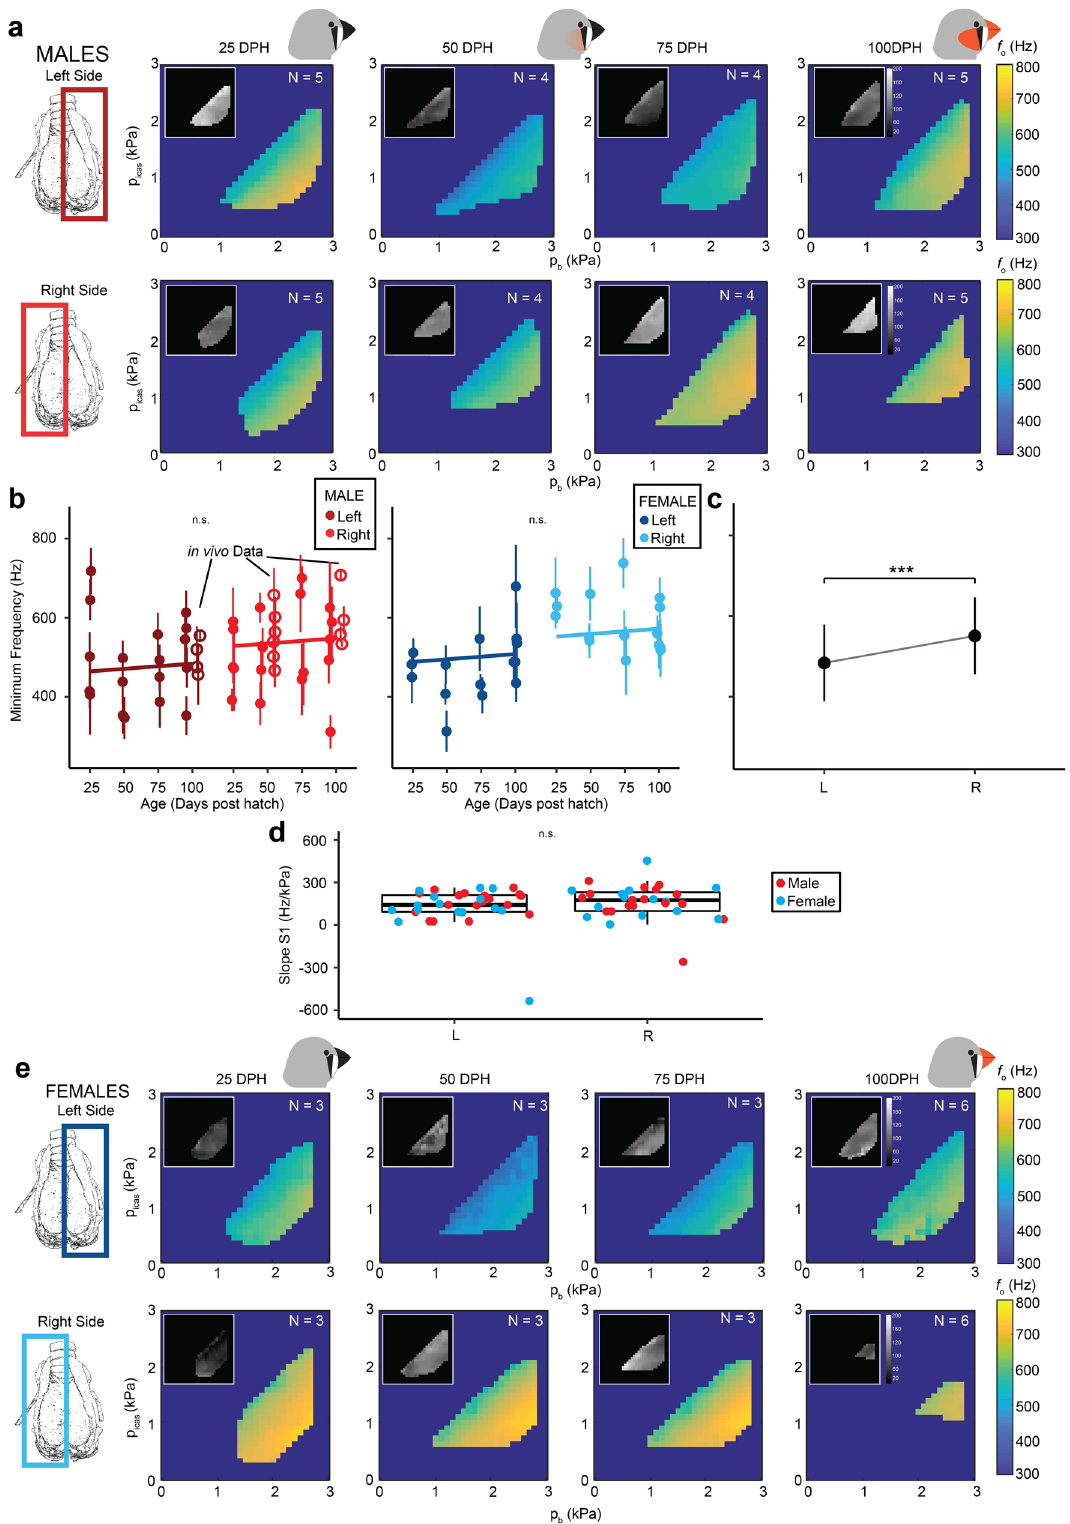
Figure 5. Minimal frequency does not change over zebra finch song development. ( a ) Mean and S.D. (inset) fundamental frequency in the p b − p icas pressure control space for the left and right hemi-syrinx in males over vocal development. ( b ) Minimum f o does not change with age in males and females. ( c ) Minimum frequency was significantly different between the left and right hemi-syrinx, regardless of age or sex. ( d ) Slope S1 for the relationship between f o and p t was not significantly different for side. ( e ) Fundamental frequency in the p b − p icas pressure control spaces for the left and right hemi-syrinx in females. For statistics see Supplementary Table S2. ***p < 0.001. Images created with Inkscape 1.0.1 (https:// inksc ape.